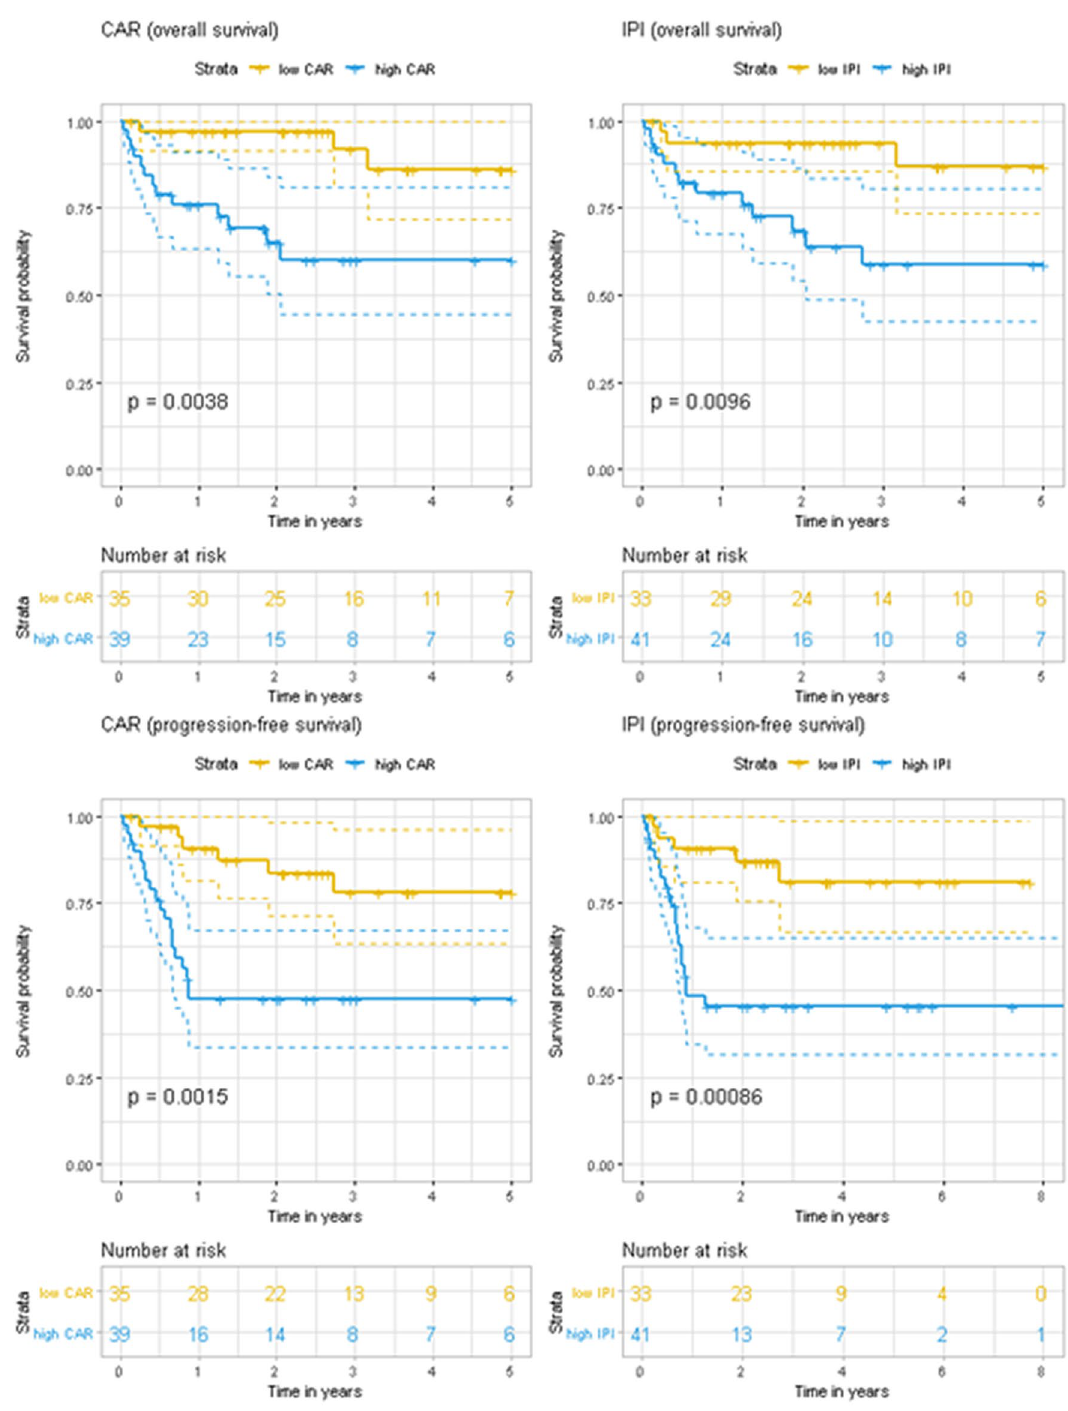
Figure 4. Kaplan–Meier curves for overall survival and progression-free survival according to the C-reactive protein-to-albumin ratio (CAR) and International Prognostic Index (IPI) among patients who were > 60 years old at the diagnosis of diffuse large B-cell